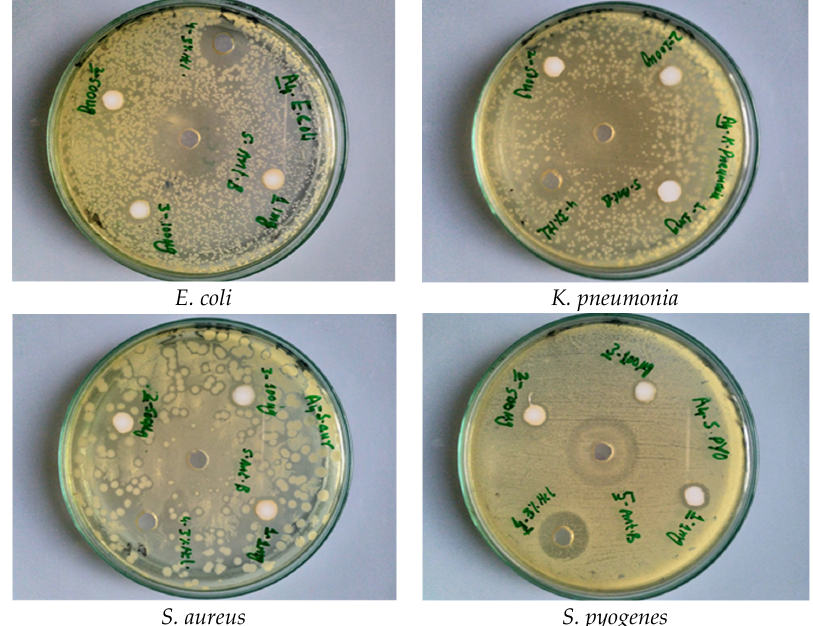
Figure 9. Zone of inhibition (ZOI) formed by ZnO against different bacteria.